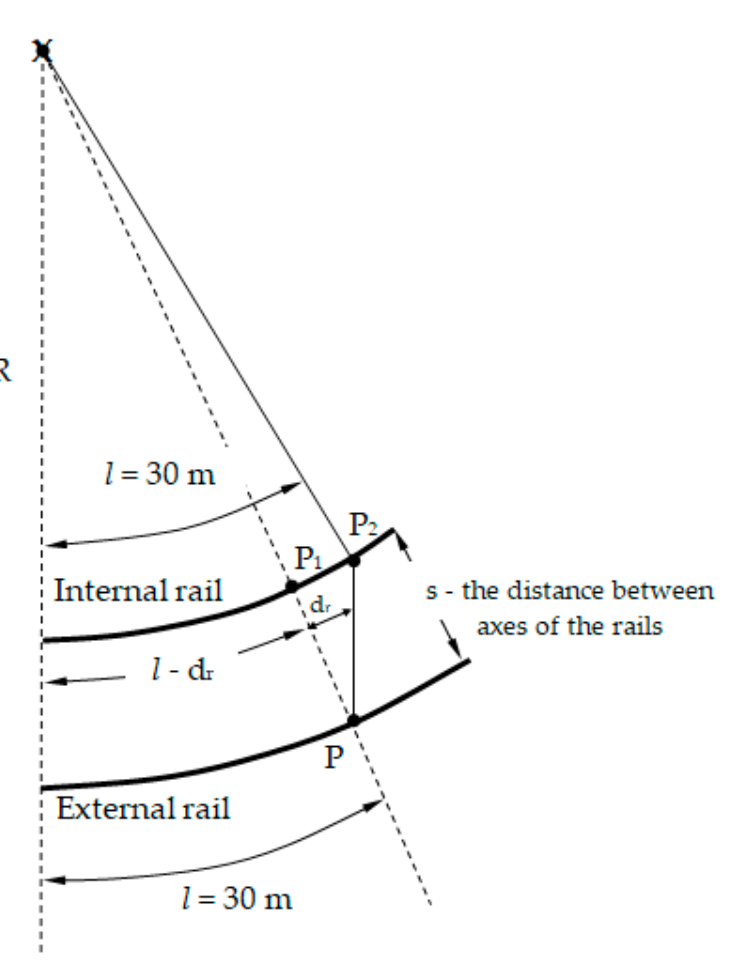
Figure 6. Measurement of the actual rail shortening (own Figure).